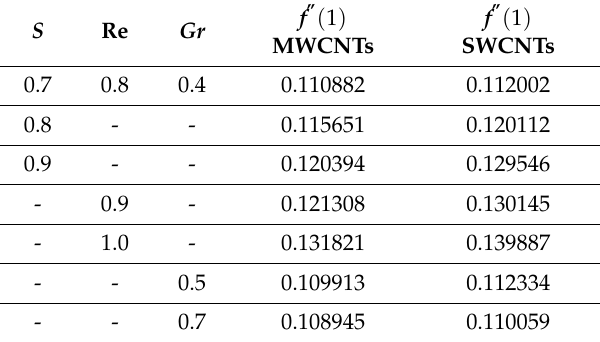
Table 4. Exhibits the Numerical values of local Nusselt number for different physical parameters,